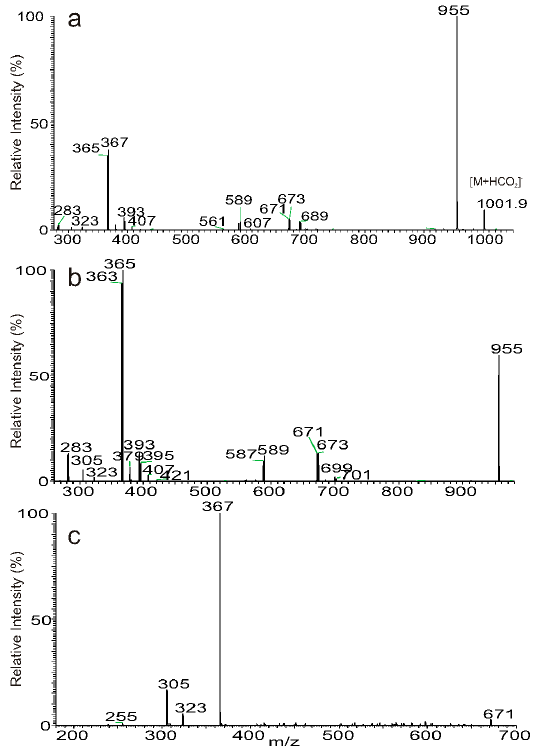
Figure 5. The negative-ion MS 2 spectrum of the [M + HCO 2 ] − ions of m/z 1001 ( a ), its MS 3 spectrum of the ions of m/z 955 (1001 → 955) ( b ), and the MS 4 spectrum of the ions of m/z 671 (1001 → 955 → 671) ( c ).